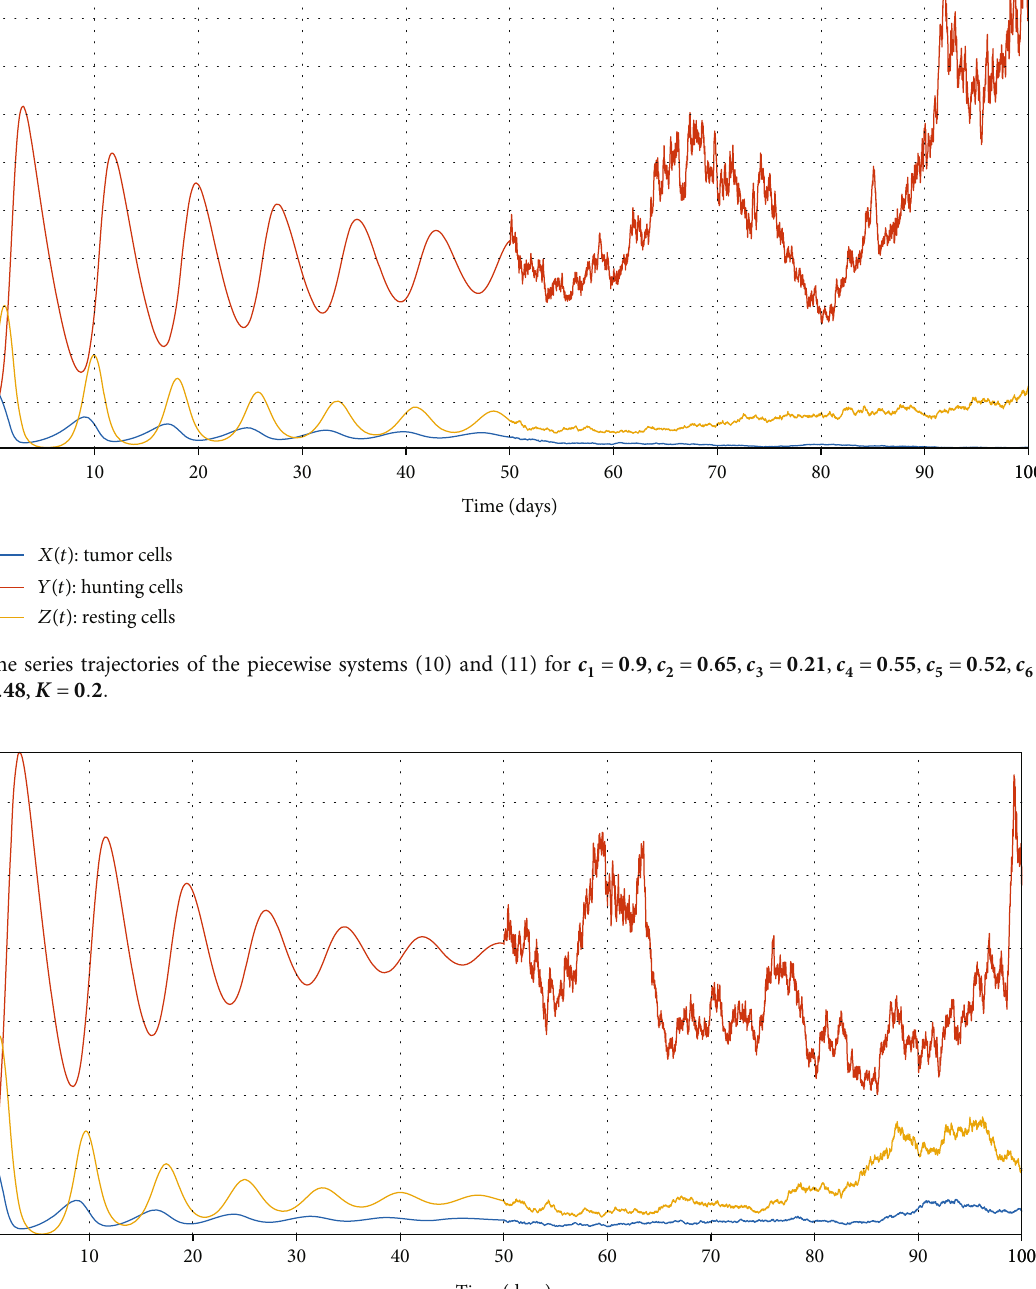
Figure 3: Time series trajectories of the piecewise systems (10) and (11) for c = 0 : 21 ,